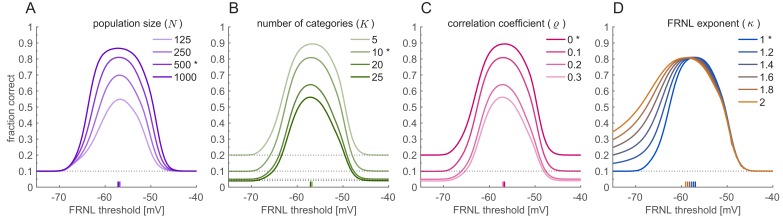
Parameter-dependence of optimal FRNL threshold.Linear decoding performance was assessed for the linear firing rate decoder under phase uncertainty as a function of FRNL threshold. Stars indicate the default values of the parameters used in other figures. Ticks on the horizontal axis show the optimal FRNL threshold. (A) Population size. (B) Resolution of the decoder. (C) Level of correlation in the noise corrupting membrane potential responses (correlations are homogeneous across all the pairs in the population). (D) Exponent of the FRNL. Parameter values match those shown on Figure 6.